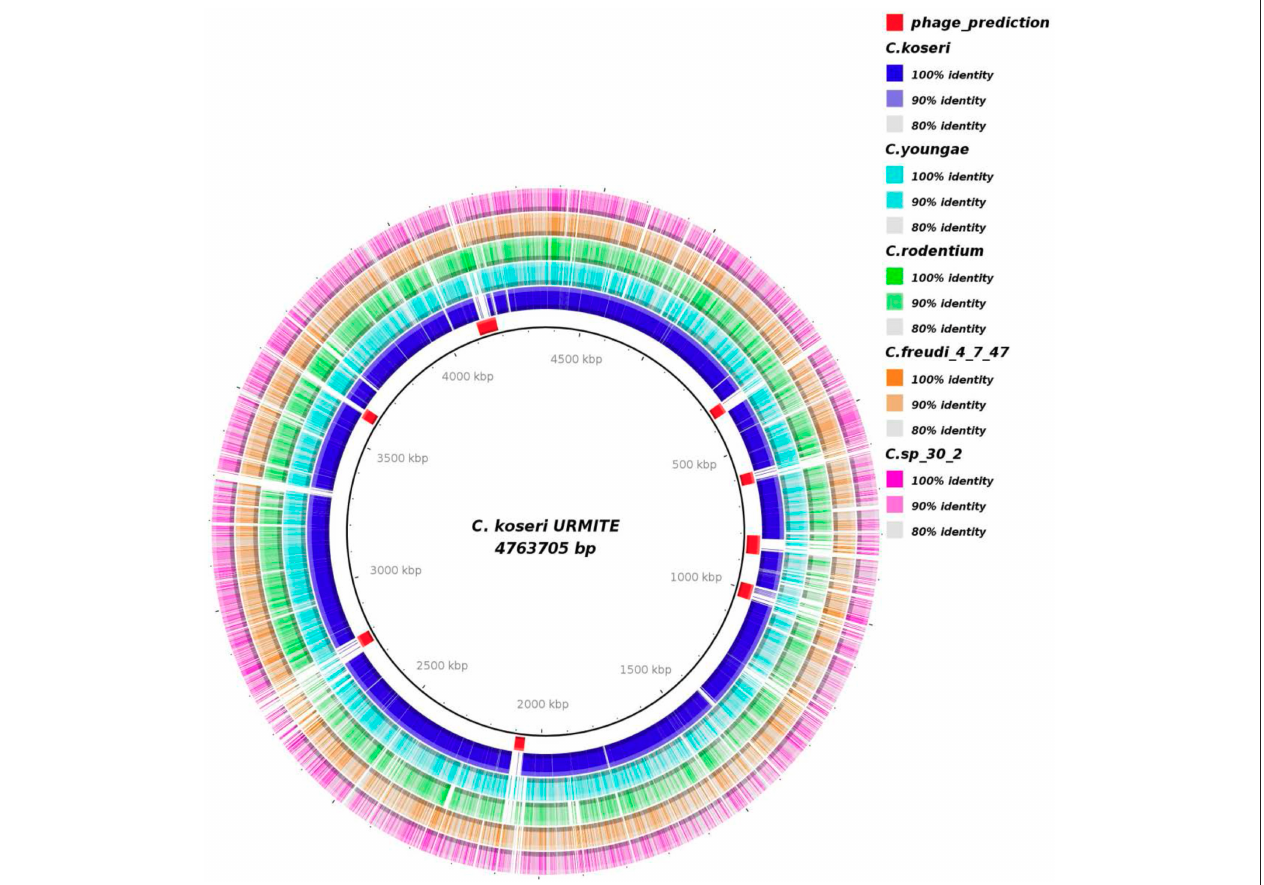
FIGURE 2 | Genomic comparison of C. koseri URMITE with other Citrobacter species. High levels of sequence identity of the Citrobacter spp. genomes with the C. koseri URMITE genome are indicated as ring with colored tiles/blocks, whereas no or weak sequence identity is shown as white tiles/blocks. The C. koseri blue ring corresponds to the C. koseri ATCC BAA-895 genome. The C. koseri URMITE specific regions are mainly annotated as prophage (red